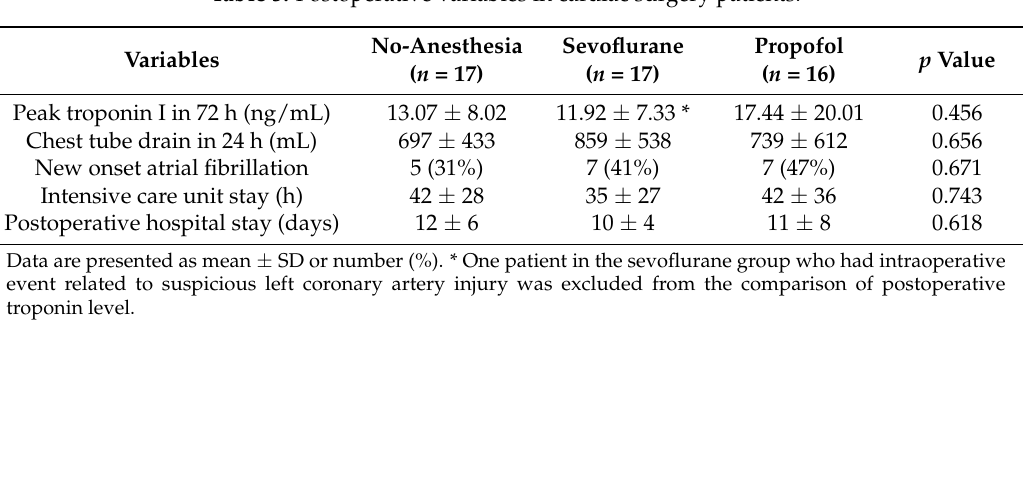
Table 3. Postoperative variables in cardiac surgery patients.